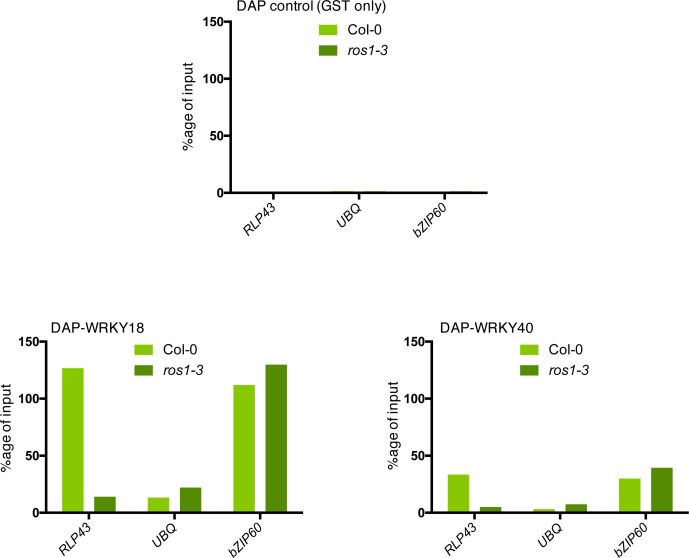
ROS1-directed demethylation is crucial for the binding of WRKY18 and WRKY40 at the RLP43 promoter.The ability of WRKY18 and WRKY40 to bind DNA corresponding to the demethylated region of the RLP43 promoter is abolished in the ros1-3 mutant background. Second biological replicate of the DAP-qPCR analysis at the RLP43 promoter upon pull-down of Col-0 or ros1-3 genomic DNA by GST (negative control) (upper panel), WRKY18-GST (left panel), or WRKY40-GST (right panel). UBQ and bZIP60 served as negative and positive controls, respectively.Figure 5—figure supplement 1—source data 1.Original DAP-qPCR data for Figure 5—figure supplement 1.